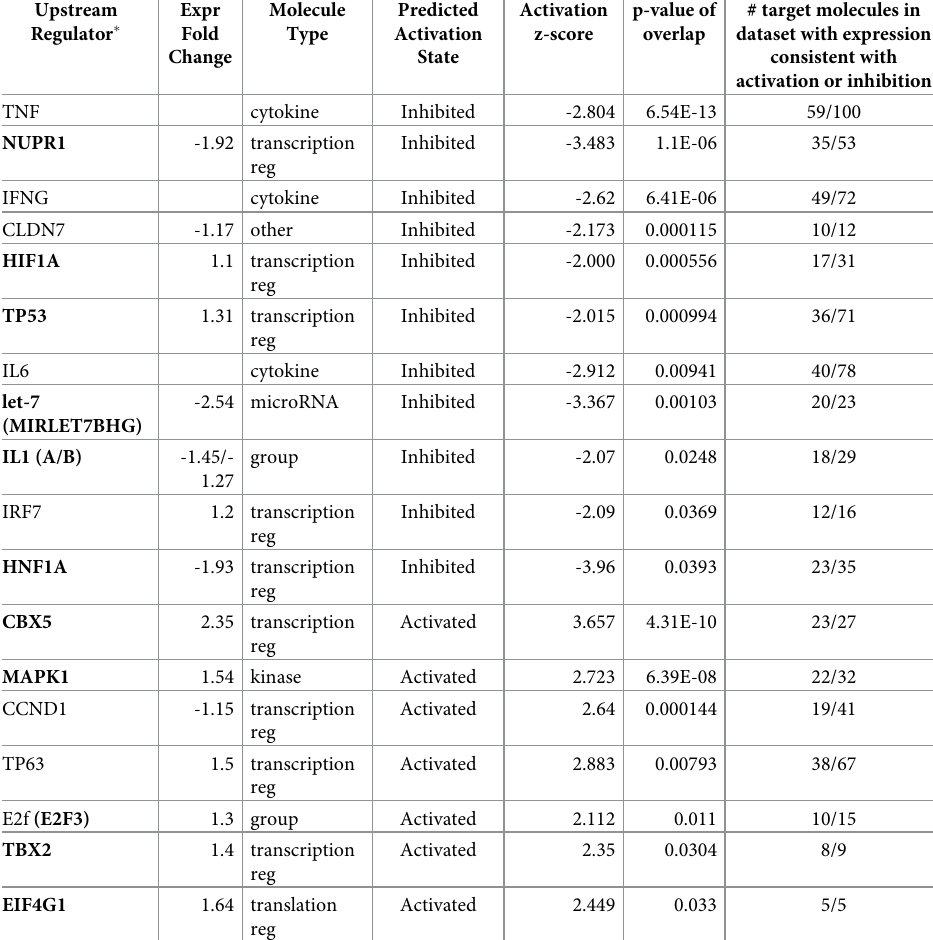
Table 5. Upstream regulators predicted for AGS-EBV tumors vs AGS tumors.